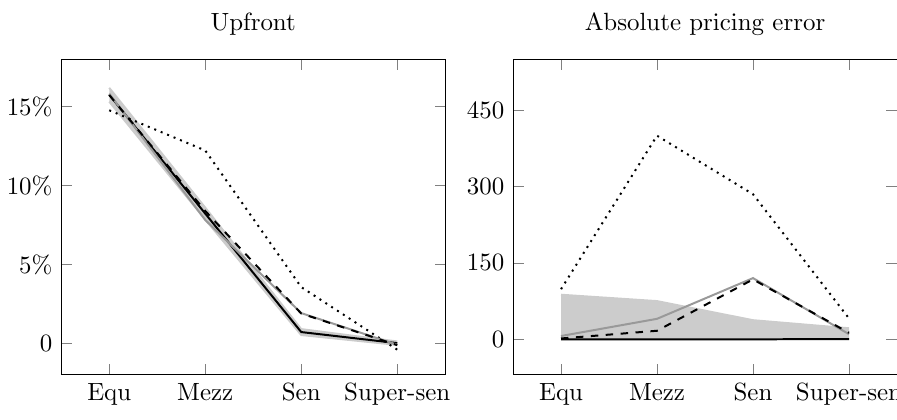
Figure 9: CDX.NA.IG.21 upfront fits (left) in percents and absolute errors (right) in basis points on January 6th, 2014. Fits for the one-factor Gaussian (dotted), the one-factor t copula (dashed), the two-factors Gaussian-Clayton copula (grey), and the one-factor mixture with two Gaussians (black). The shaded area is the bid-ask